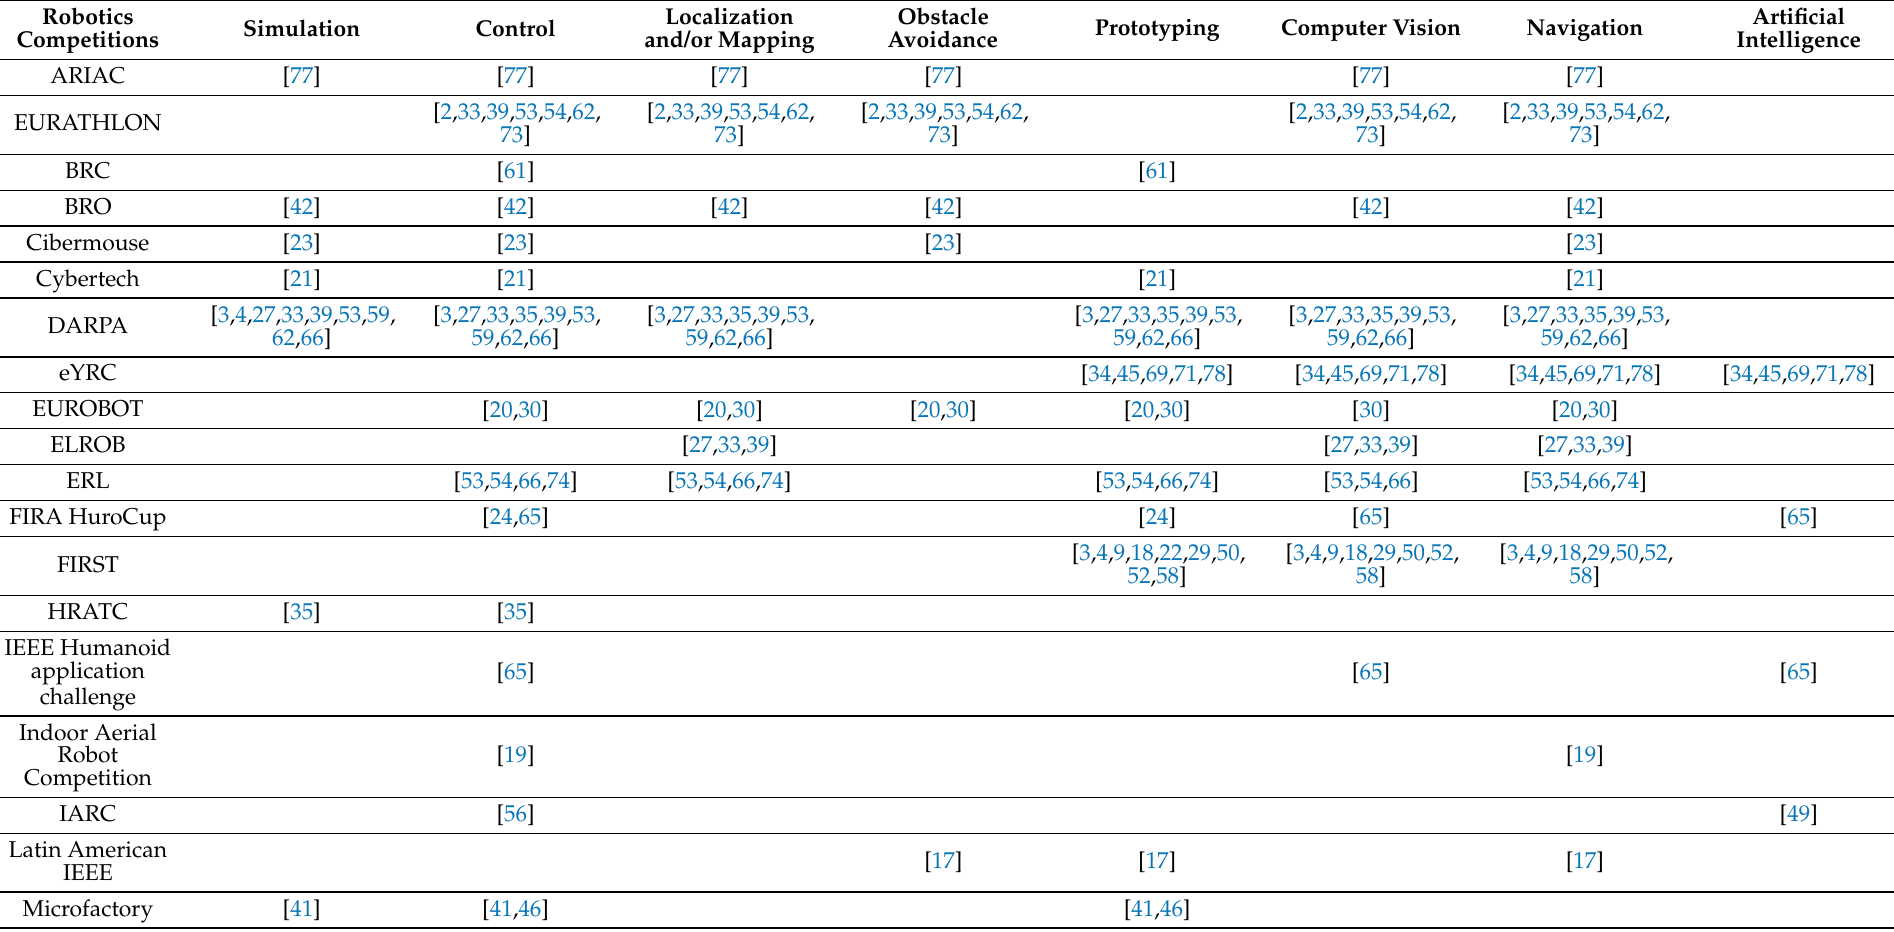
Table 5. Research topics associated with the mobile robotics competitions and related